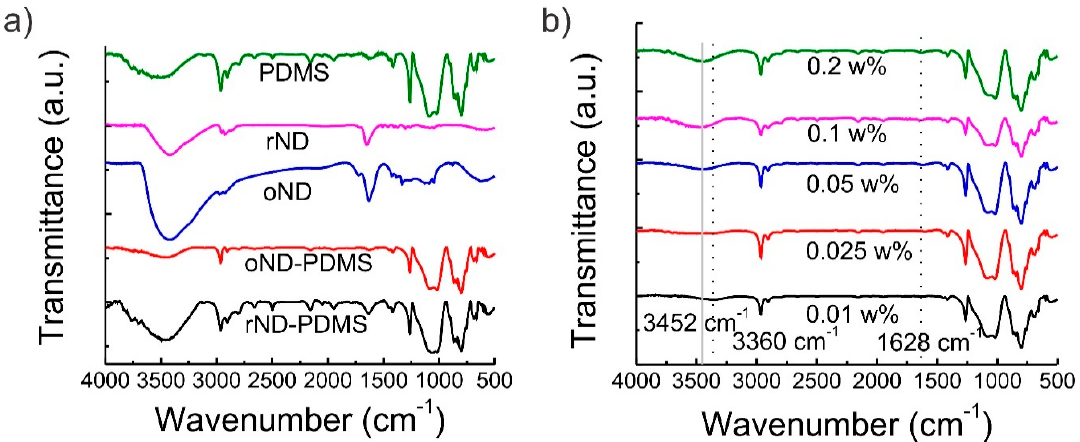
Figure 4. ( a ) FTIR transmission spectra of PDMS (green), reduced (H-terminated) ND (purple), oxidized ND (blue), PDMS / oND composite with 0.1 wt % oND, and PDMS / rND composite with 0.1 wt % rND. ( b ) FTIR transmission spectra of PDMS / oND particles dependent on the concentration of the oND particles. The concentration ranged between 0.01 and 0.2 wt %.